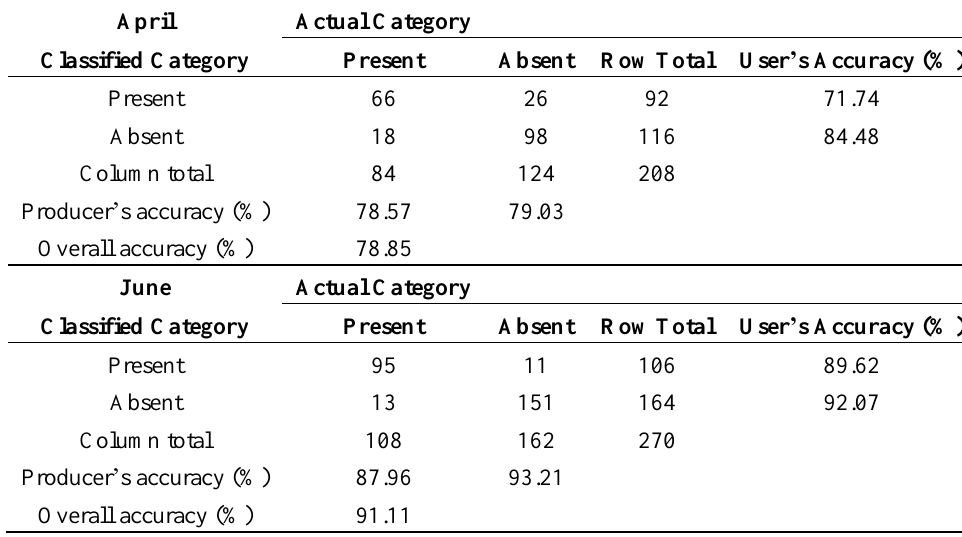
Table 4. Confusion matrices (top for April and bottom for June image classifications) generated from the ground verification and classified data for musk thistle, other vegetation and non-vegetation